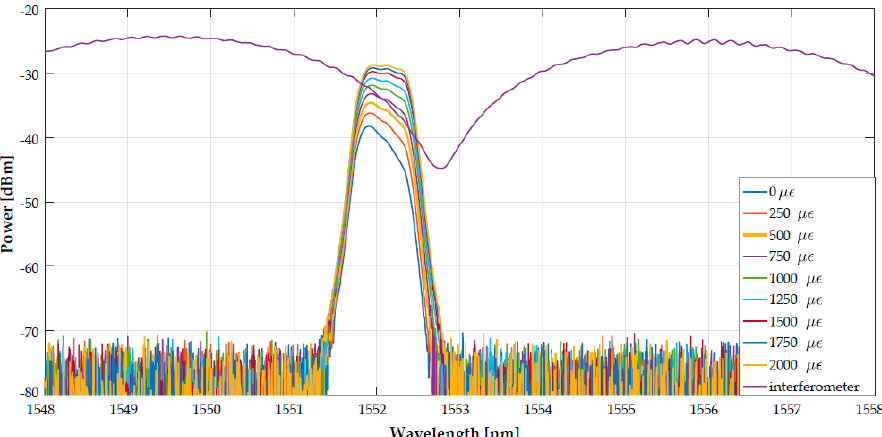
Figure 5. The output light spectra for different stretched PM-PCF.